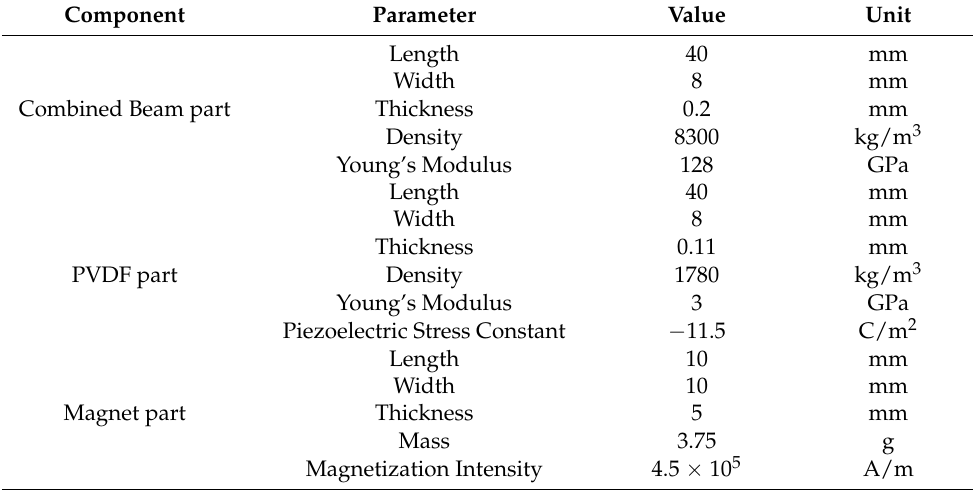
Table 1. Simulation parameters of the